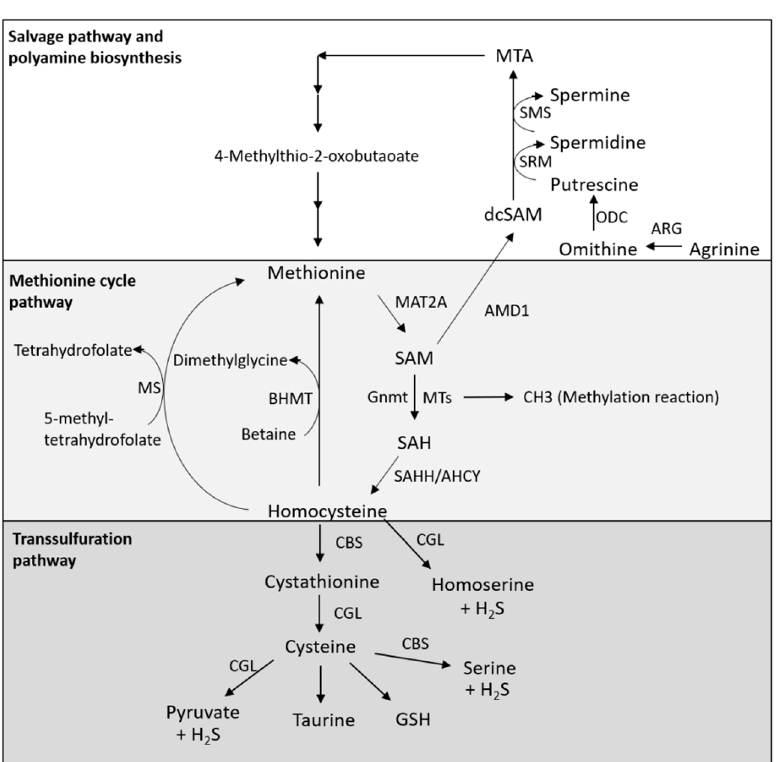
Figure 1. Methionine metabolism. Methionine cycle pathway: Methionine is catabolized by methionine adenosyltransferase 2A (MAT2A), producing the methyl donor S-adenosyl-methionine (SAM). Methyltransferases (MTs), including glycine N-methyltransferase (Gnmt), use SAM as a methyl source, thereby producing S-adenosyl-homocysteine (SAH). SAH is then converted by